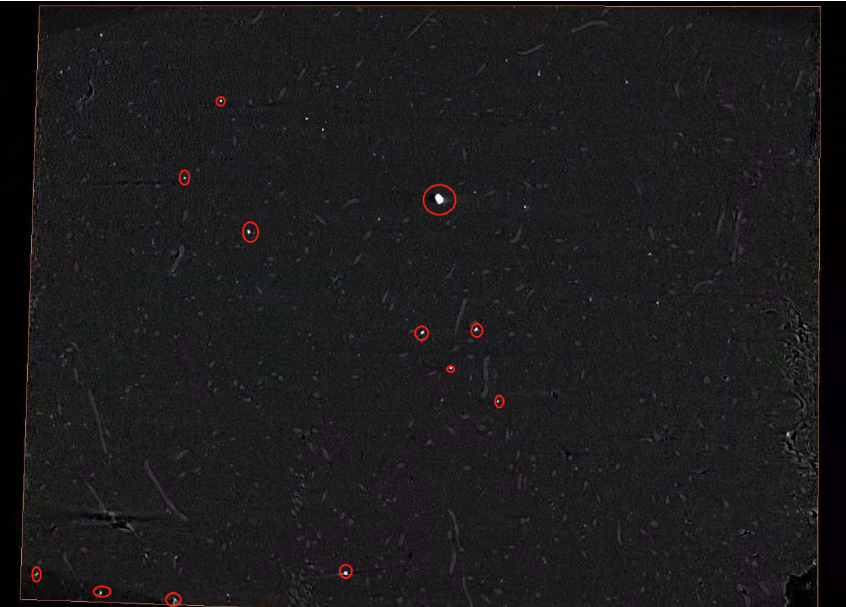
Figure 5. Slice image of a polyester-short-fiber-reinforced rubber composite sample before binarization treatment.